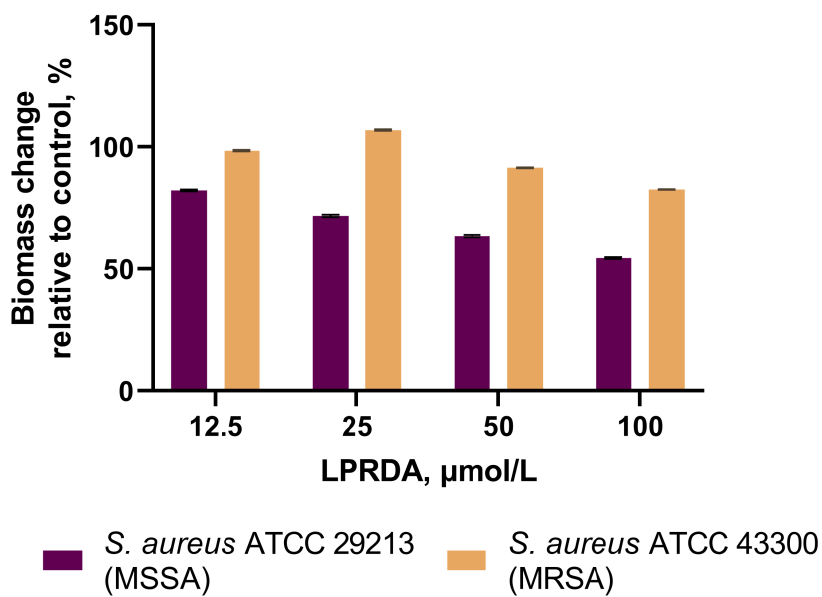
Figure 4. Inhibition of S. aureus biofilm formation relative to the control after incubation with various concentrations of the oligopeptide LPRDA.